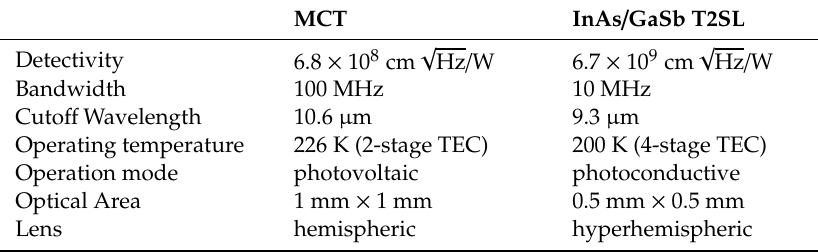
Table 2. Specifications of the two IR detector modules, based on an MCT detector and an InAs / GaSb T2SL detector,